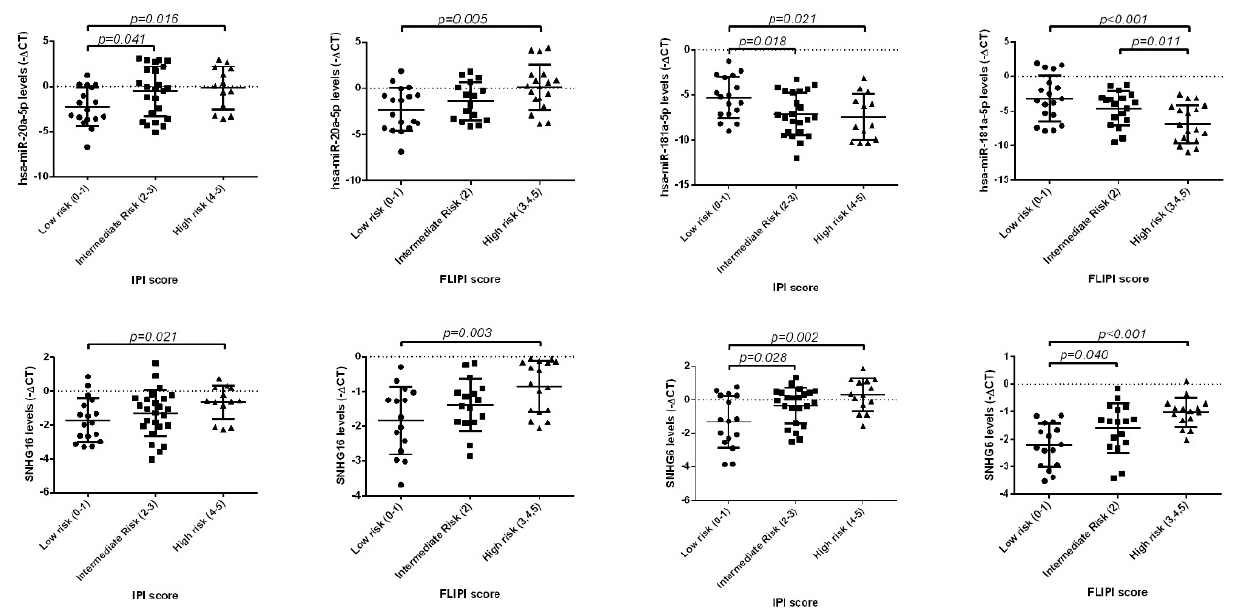
Figure 7. Expression levels of hsa-miR-20a-5p, hsa-miR-181a-5p, SNHG16 and SNHG6 in plasma samples of NHL patient groups according to IPI and FLIPI scores. High levels of hsa-miR-20a-5p, SNH16 and SNHG6 were associated with higher IPI and FLIPI scores, while low levels of hsa-miR- 181a-5p were associated with higher IPI and FLIPI scores. The figures represent the −Δ CT of miRNA expression normalized to the endogenous control (mean ± SD).